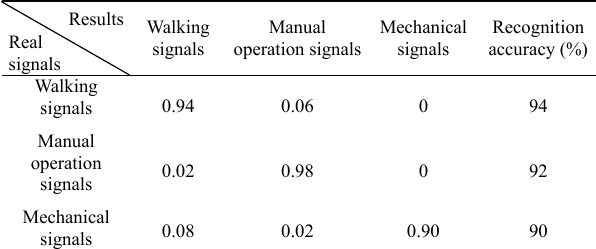
Table 3 Classification results of